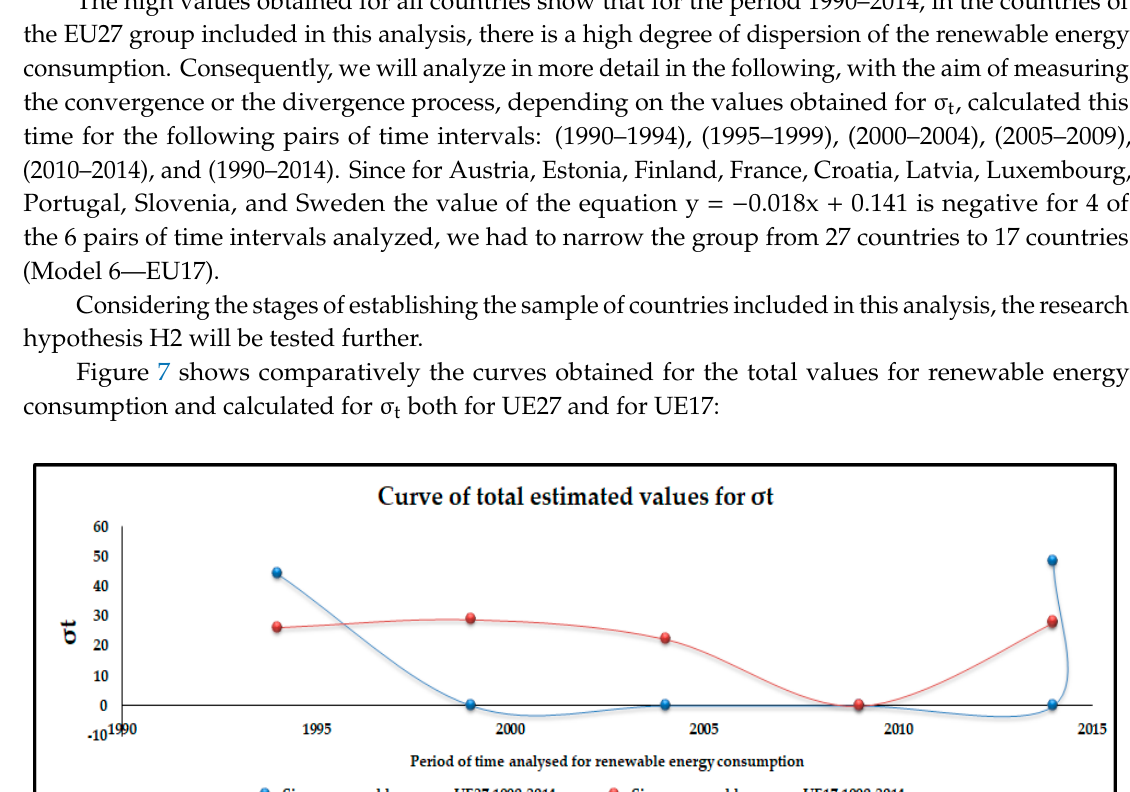
t for renewable energy